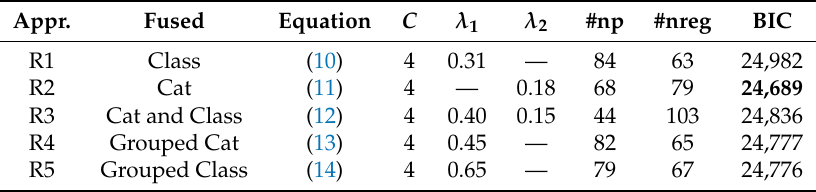
Table 7. Data illustration polytomous data: model comparison for different RLCMs with four classes.